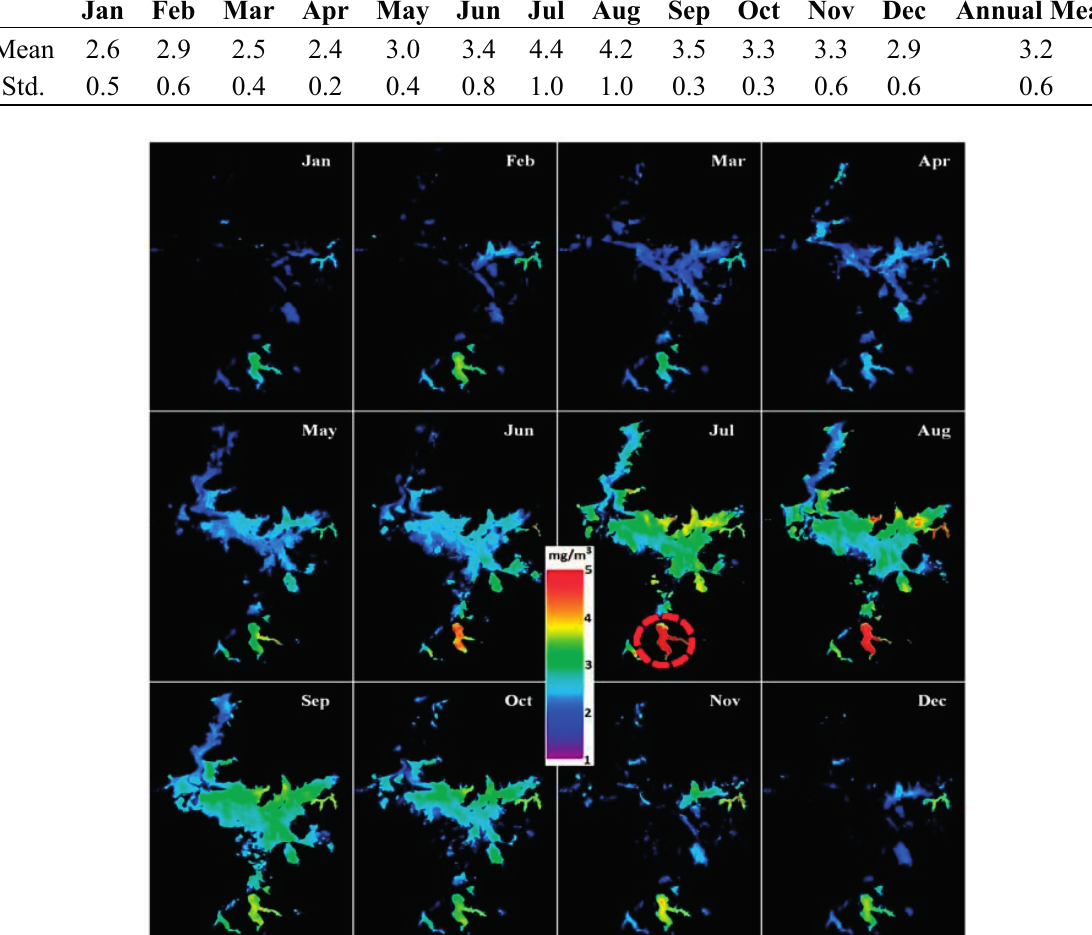
Figure 8. MERIS-derived Chl-a distributions in Poyang Lake during each climatological month between 2003 and 2012. Each panel was derived as the average of that month from all of the years. Note the significant seasonality in coverage due to lake inundation changes